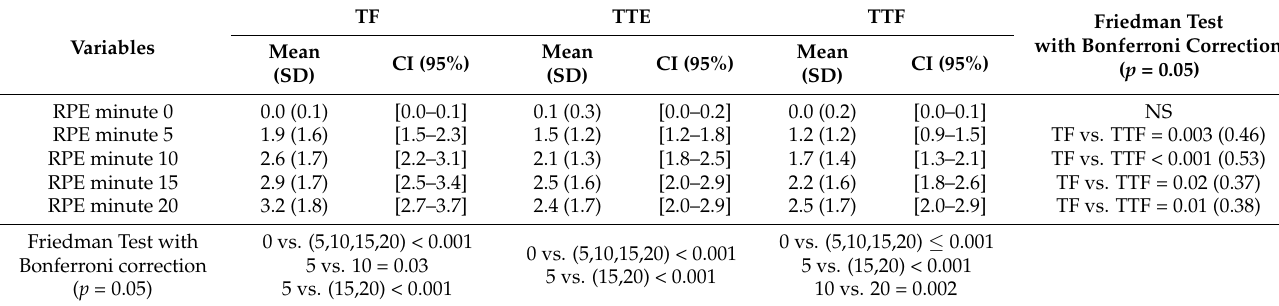
Table 2. Results of Rating of Perceive Exertion (RPE). ( n = 56; 2